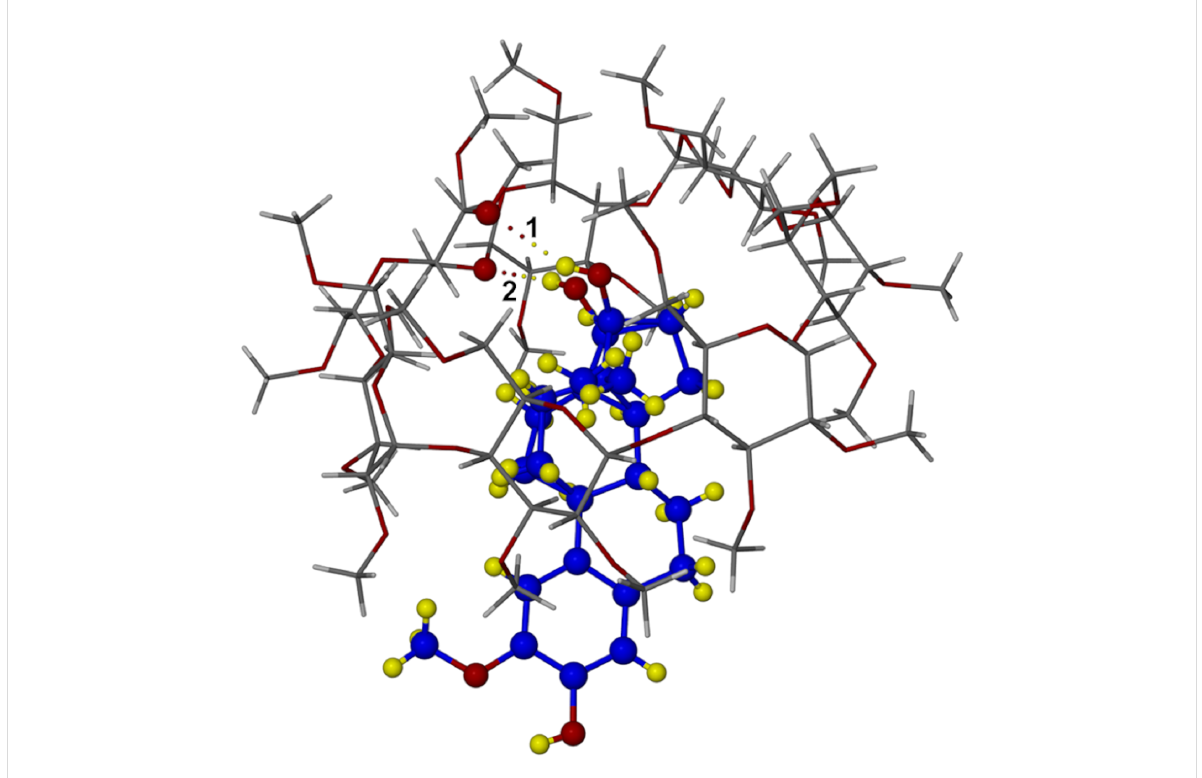
Figure 7: The TRIMEB·2ME complex unit D with two distinct (guest)O19-H···O(host) hydrogen bonds highlighted. To distinguish the host and guest, C and H atoms of 2ME are coloured blue and yellow respectively.